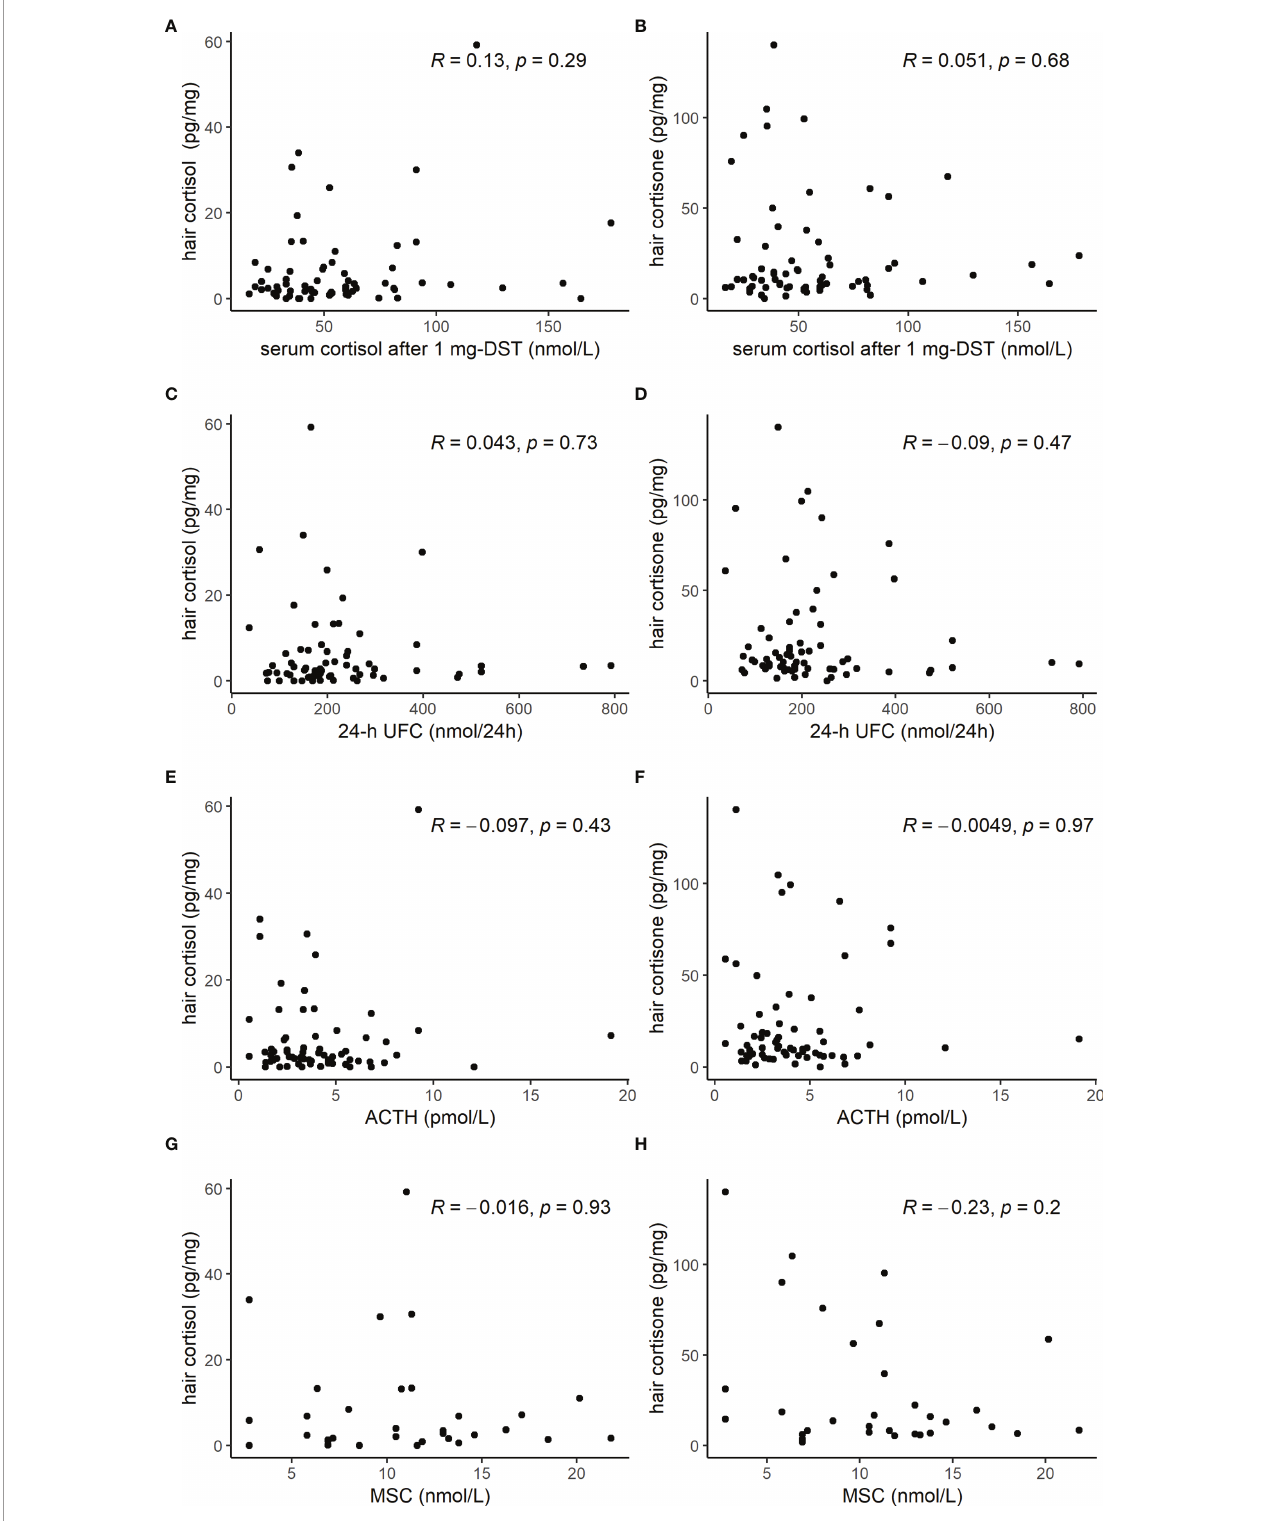
FIGURE 3 | Scatterplot of hormone tests [cortisol after 1 mg dexamethasone suppression test (DST), 24-h urinary free cortisol (UFC), adrenocorticotropic hormone (ACTH), and midnight salivary cortisol (MSC)] and hair cortisol (A, C, E, G) or hair cortisone (B, D, F, H) levels, showing the lack of any signi fi cant